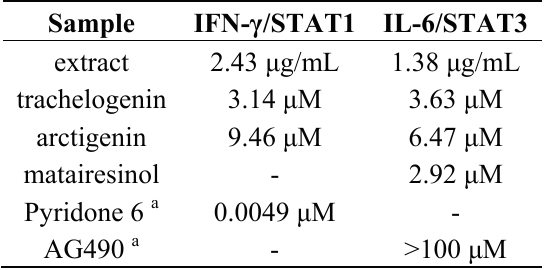
Table 2. IC values of the extract and active compounds from Caulis Trachelospermi on 50 IFN- γ /STAT1 and IL-6/STAT3 pathway.